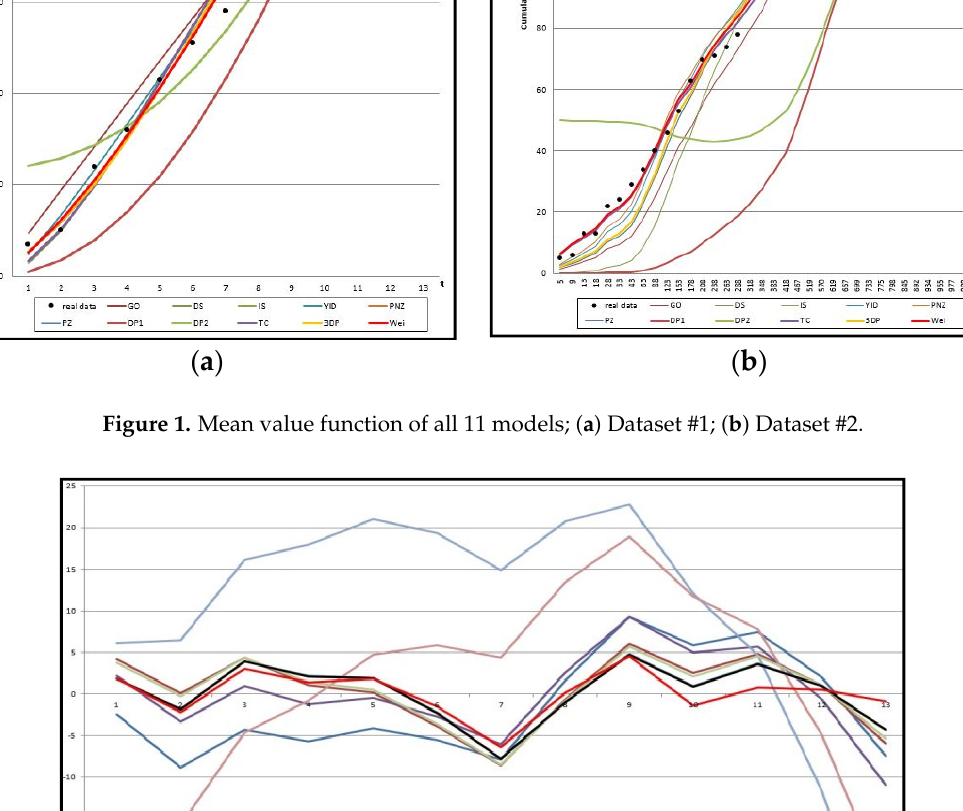
Figure 3. Relative error value of 11 models in Table 1 for Dataset #2. ( a ) ( b ) Figure 4. Confidence intervals of the proposed new model; ( a ) Dataset #1; ( b ) Dataset #2.